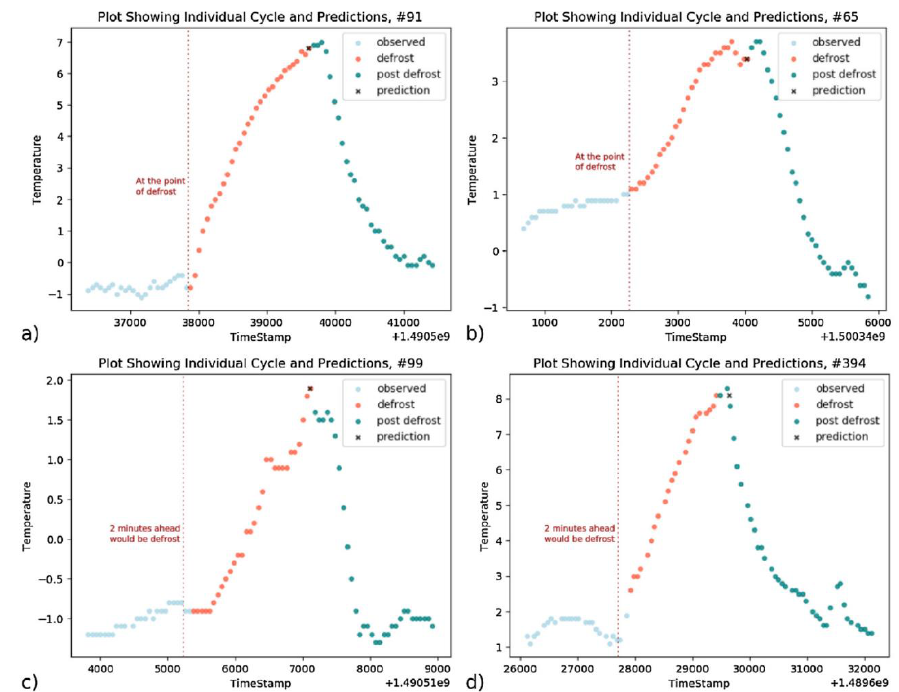
Figure 7. Prediction of the defrost time in four different refrigerator cases ( a – d ): in each case “Observed” (light blue) denotes training data; “defrost” (orange) is the ground truth; “prediction” ( × ) is the prediction of the final ground truth (orange)